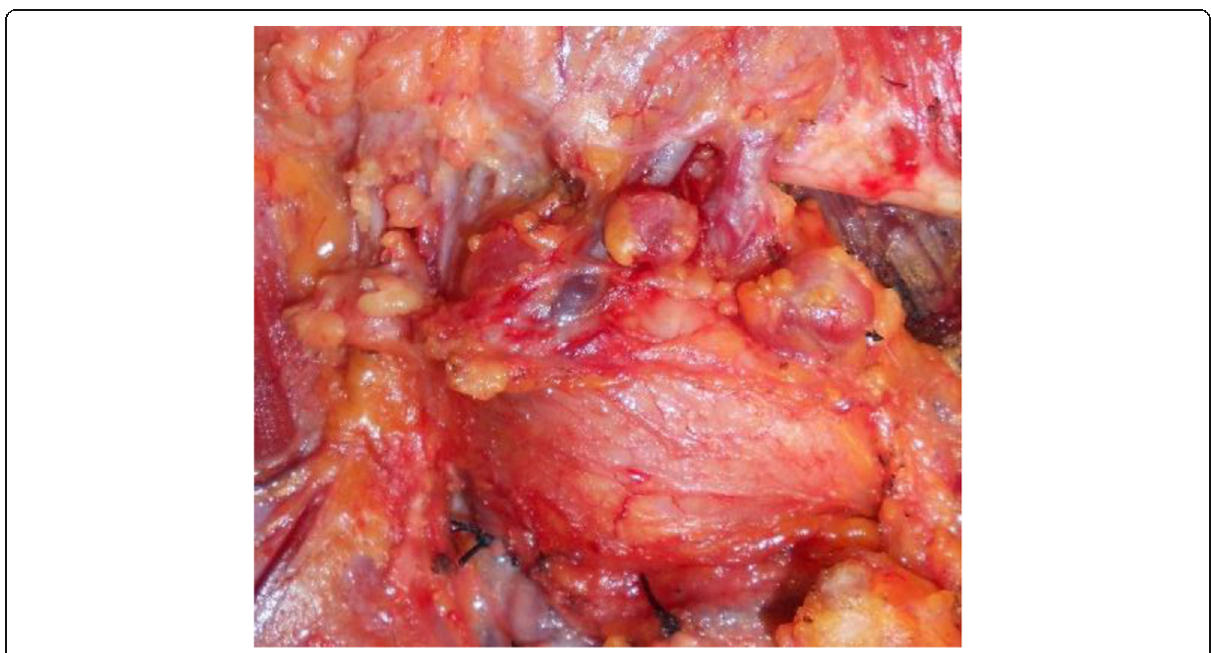
Fig. 24 Relation of MMN to perifacial